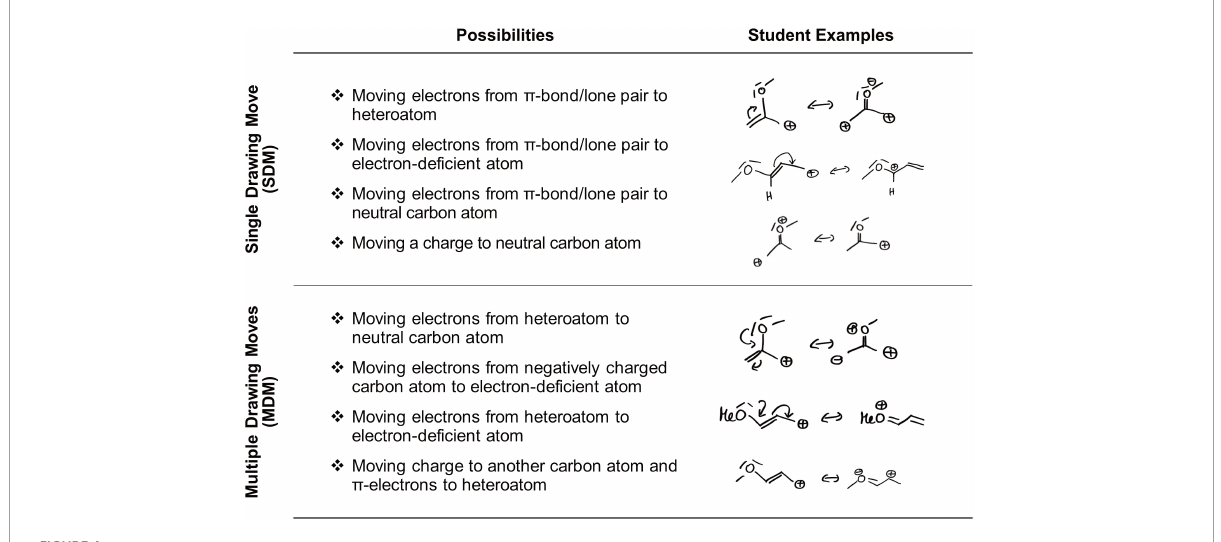
FIGURE4 Coding scheme for drawing moves with student